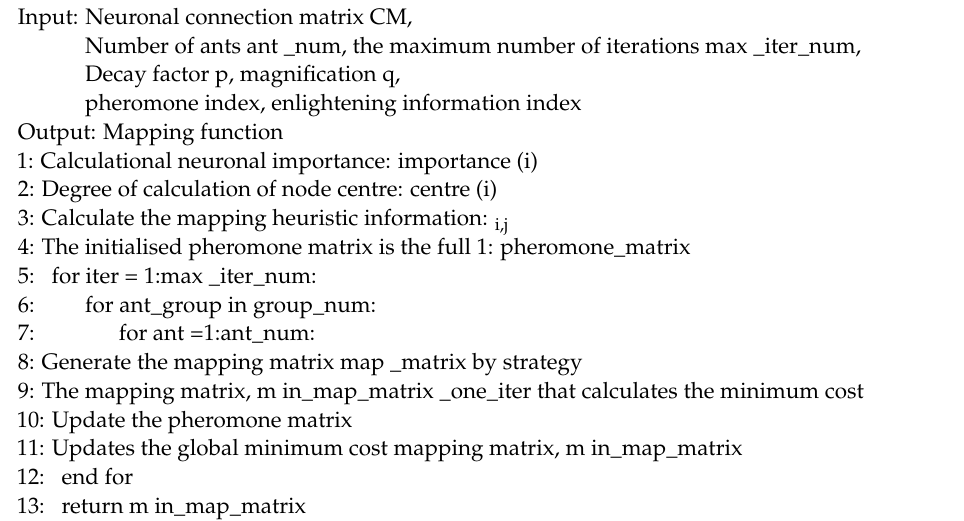
Algorithm 1: Given the neuron connection matrix and the number of nodes, iteratively optimise 2D Mesh mapping